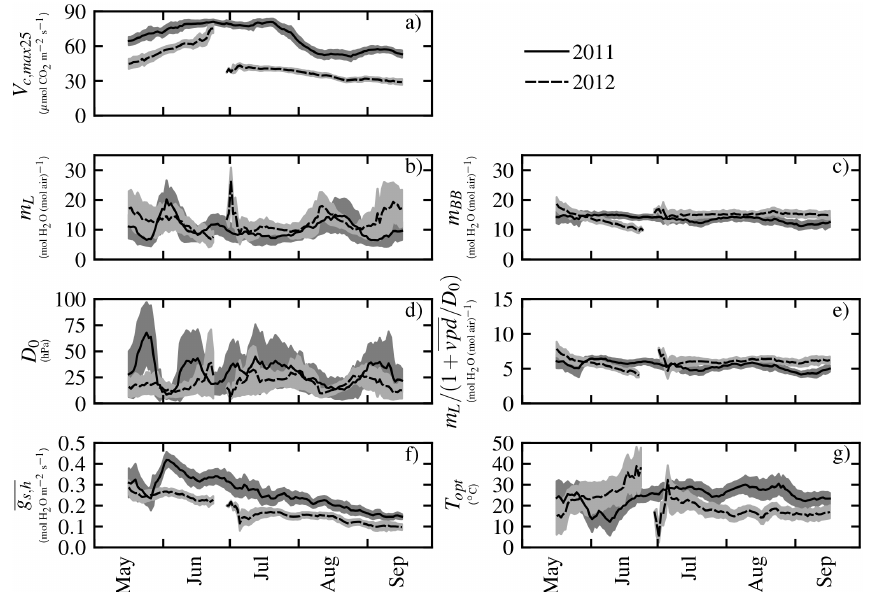
Figure 7. Daily values for (a) apparent maximum carboxylation rate at 25 ◦ C V c,max25 , (b) assimilation sensitivity parameter m L of the Leuning model, (c) assimilation sensitivity parameter m BB of the Ball–Berry model, (d) vapour pressure deficit sensitivity parameter D 0 , (e) fraction m L /( 1 + ( vpd /D 0 )) relating assimilation A and stomatal conductance g s , (f) daily median stomatal conductance for water vapour g s,h during daytime, and (g) optimal temperature of electron transport T opt . The model is fitted to median daily cycles of gross primary productivity GPP o and evapotranspiration ET o of the Q. suber trees in a 31day long moving window for the summer period of 2011 (solid line, dark uncertainty band) and 2012 (dashed, light uncertainty